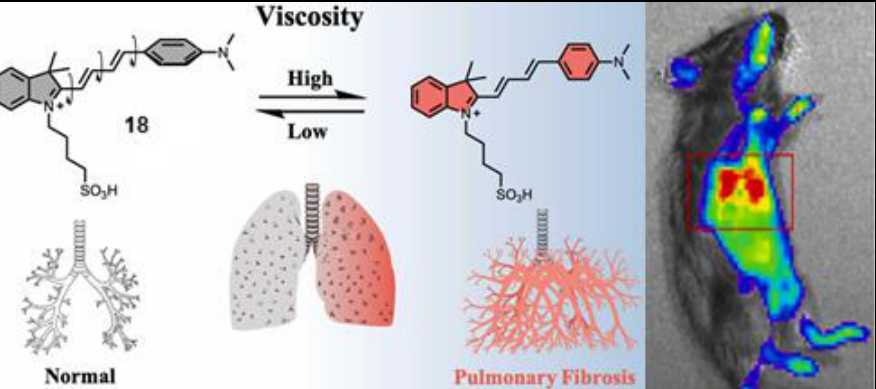
Figure 19. Transformation of probe 18 in monitoring viscosity fluctuation in idiopathic pulmonary fibrosis. In vivo imaging of bleomycin-induced IPF mice model in 14 days, λ EX = 640 nm, λ F = 700 nm. Adapted with permission from [ 85]. Copyright (2022) Elsevier.